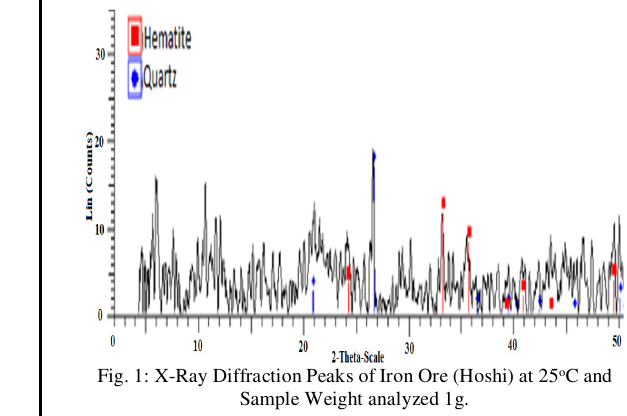
Fig. 1: X-Ray Diffraction Peaks of Iron Ore (Hoshi) at 25 o C and Sample Weight analyzed